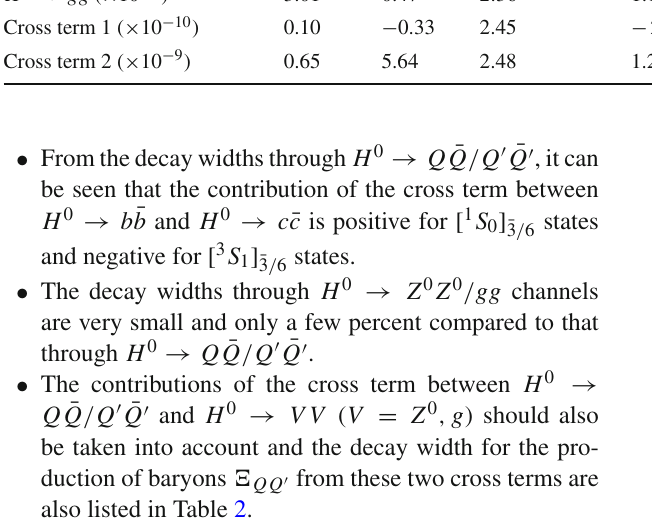
and H 0 → Z 0 Z 0 , and Cross term 2 is the cross term